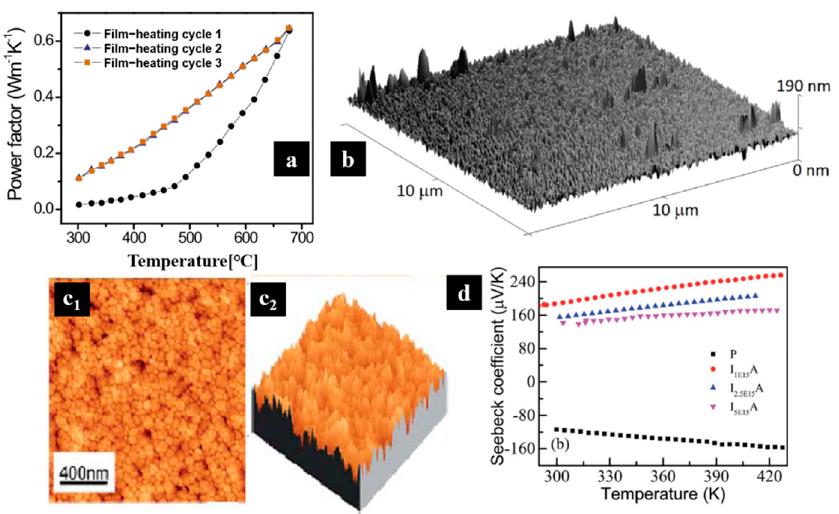
Figure 8. ( a ) Temperature dependence of power factor for In and Yb doped CoSb 3 films [60]; ( b ) AFM image of Yb-filled CoSb 3 film material surface [61]; ( c 1 , c 2 ) 2D and 3D AFM images of single − phase CoSb 3 film; ( d ) temperature dependence of Seebeck coefficient for single-phase CoSb 3 and Fe − doped CoSb 3 film [62]. P is untreated single-phase CoSb 3 film. I 1E15 A, I 2.5E15 A and I 5E15 A are CoSb 3 films annealed rapidly and added with 1 × 10 15 , 2.5 × 10 15 or 5 × 10 15 iron ions per square centimeter, respectively.